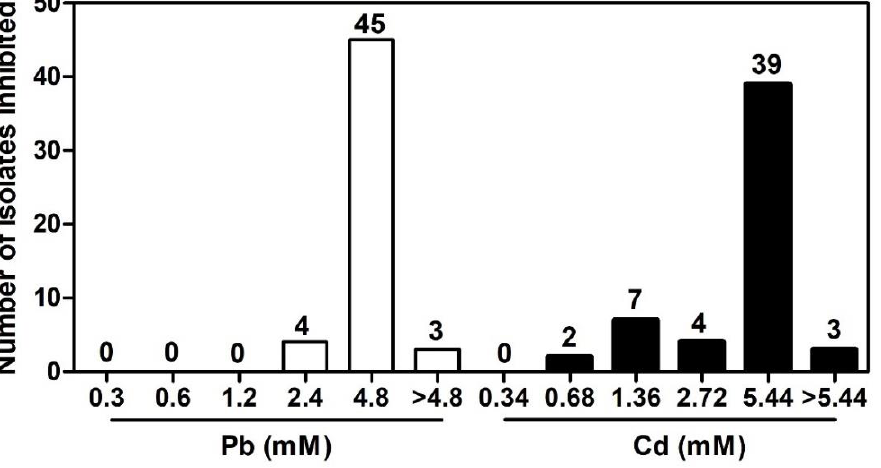
Figure 1. Minimum inhibitory concentrations (MIC) of Pb and Cd for bacterial isolates from Typha latifolia roots. The values above the bar show the number of isolates inhibited at each Pb or Cd concentration.